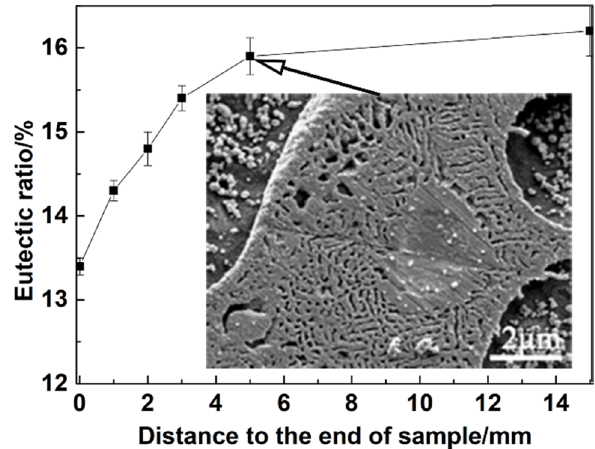
Figure 4: Variation curve of the content of Ag and Cu elements at the end of cold - type vertical continuous casting Cu – 20% Ag alloy bar billet.